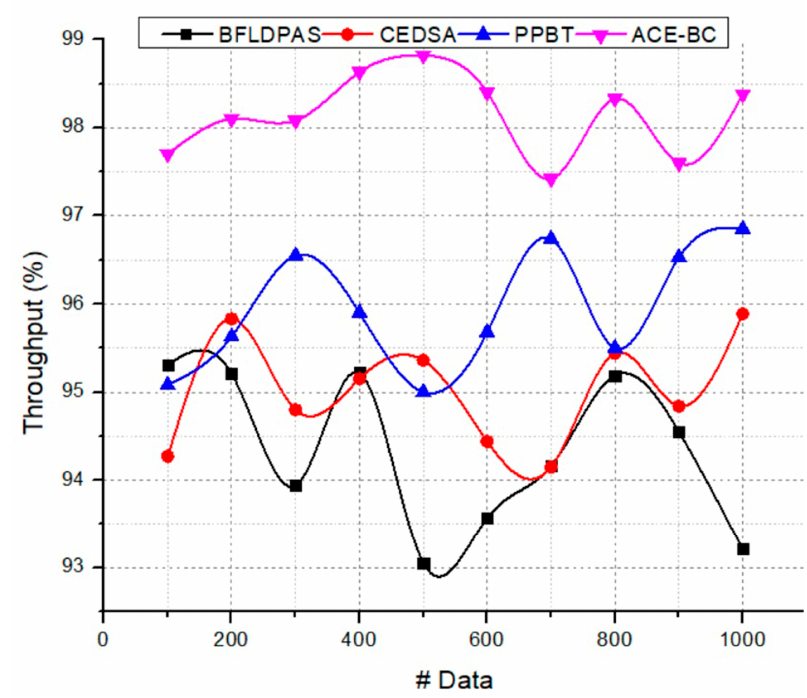
Figure 6. Throughput ratio.